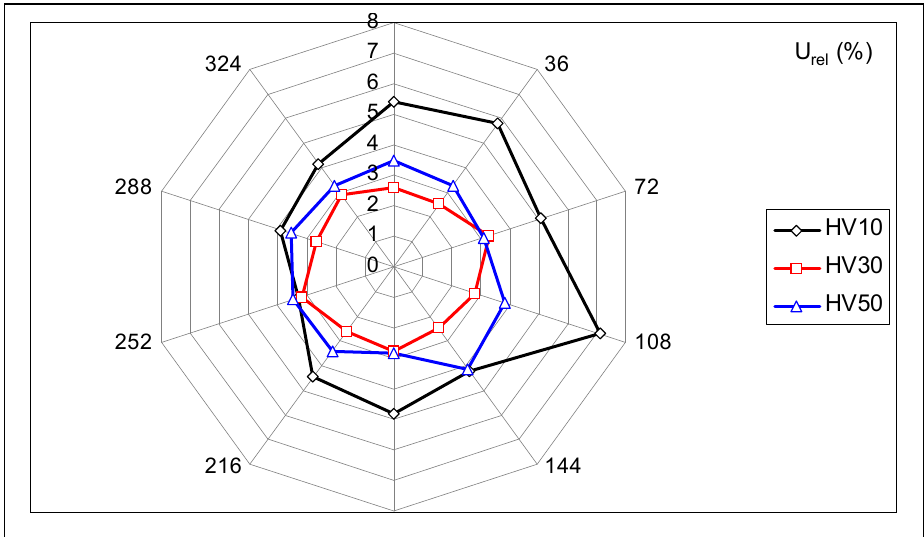
Figure 4 - The influence of the rotation of indenter on the uncertainty